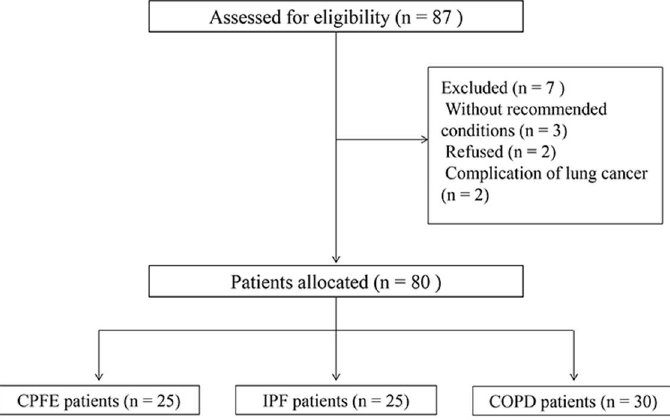
Fig 1. Study flow